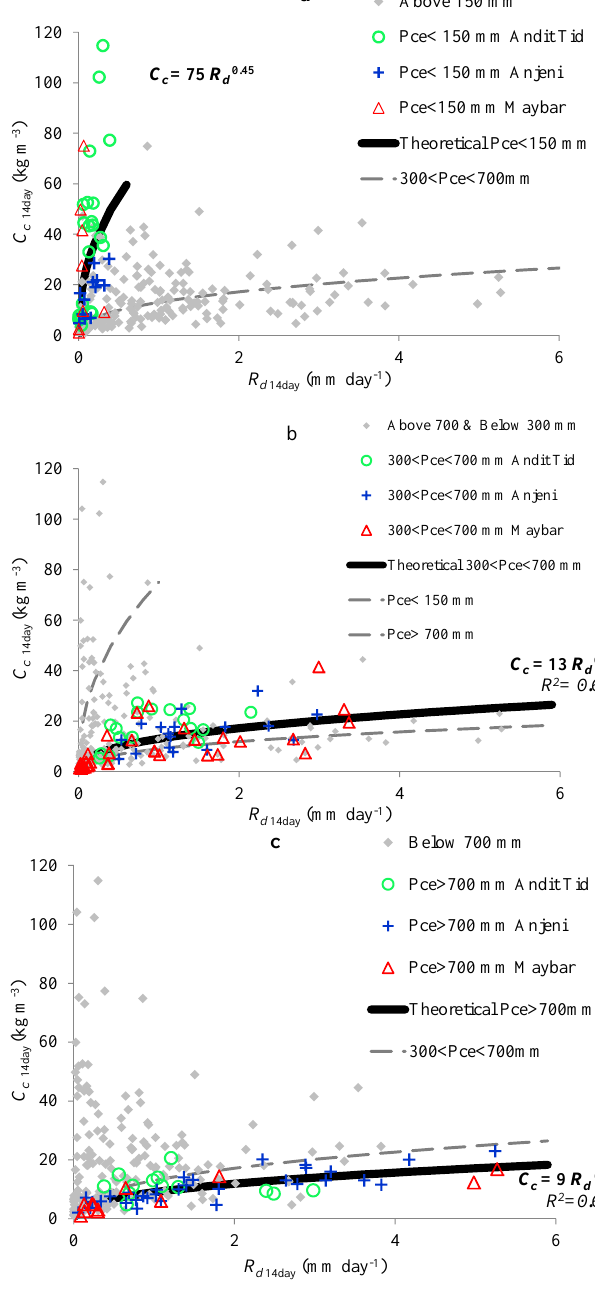
Fig. 5. Andit Tid, Anjeni, Maybar average storm sediment concentration per unit cropland ( C c in kg m -3 ; y-axis) and runoff depth ( R d in mm day -1 ; x-axis) over a 14-day period during the rainy phase of the monsoon (a) early part (b) middle part and (c) late part. The ranges of cumulative effective precipitation are given in the legends.